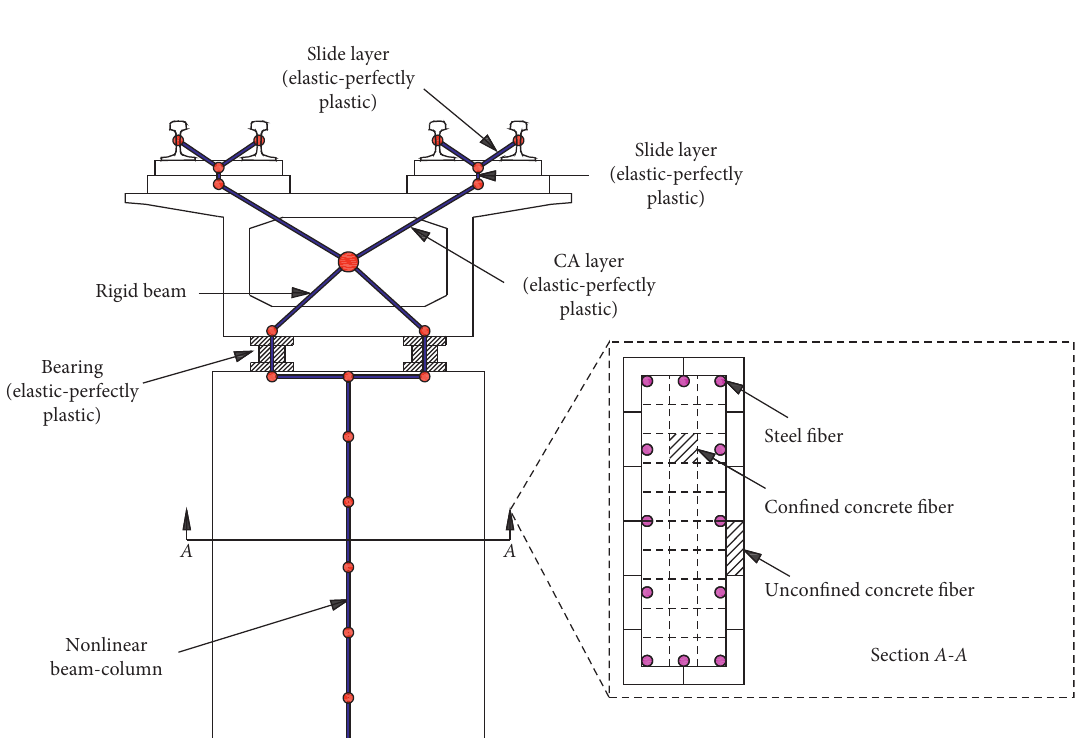
Figure 7: Vertical view of modeling scheme for HSRB